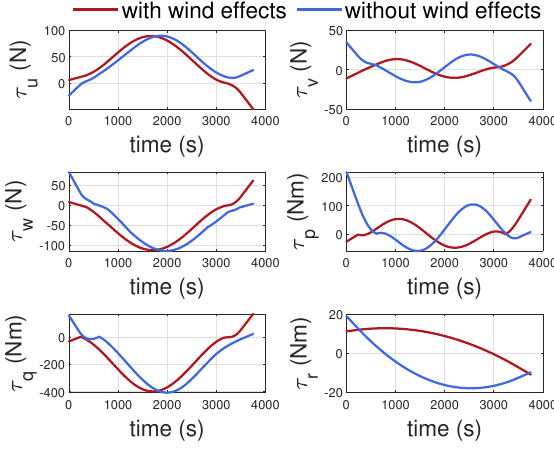
Figure 10. Control forces and torques of the airship.